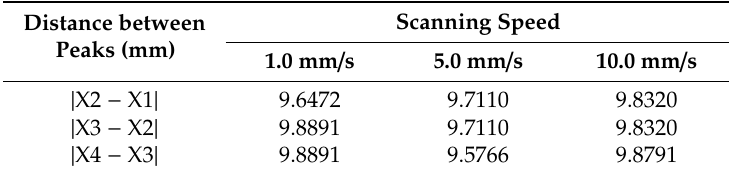
Table 4. Distance between adjacent peaks in the temperature-distance plots obtained under different speeds.